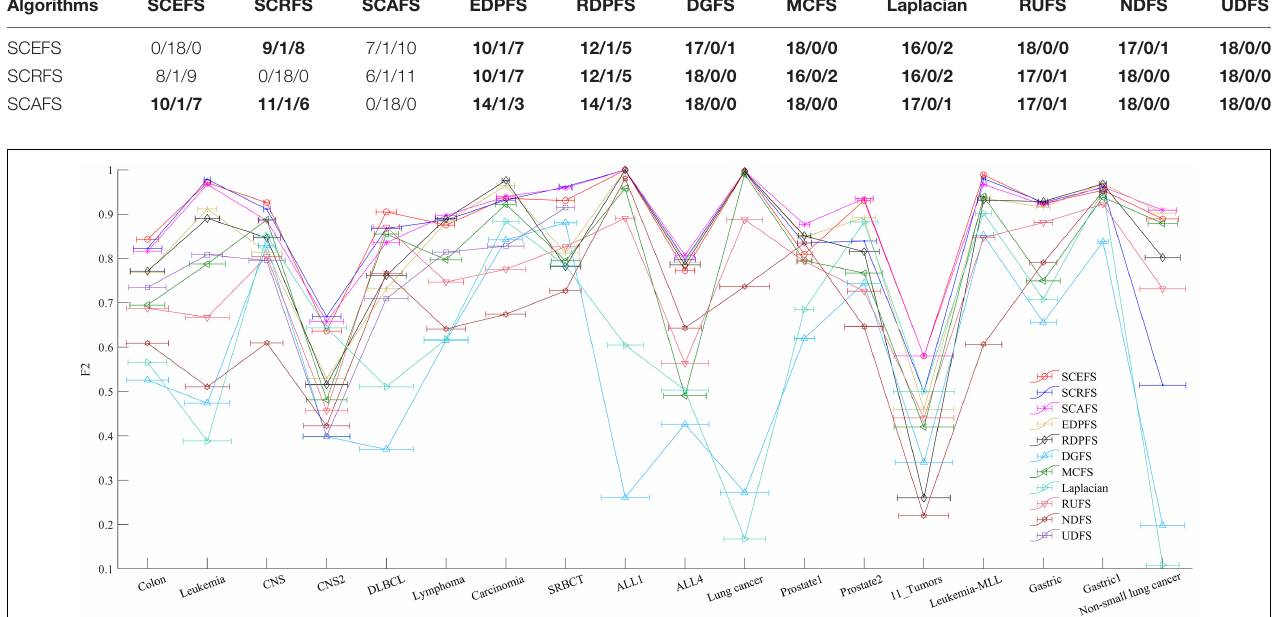
TABLE 4 | The comparison between proposed algorithms and other algorithms in terms of win/draw/loss based on the maximal mean Acc. Algorithms